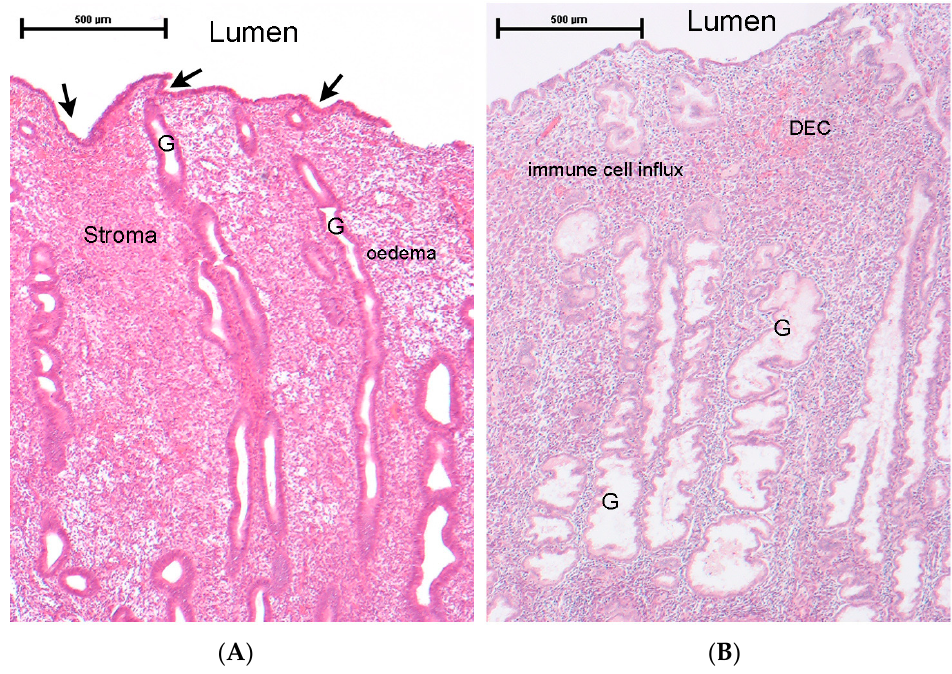
Figure 1. Histology of the human endometrium during the normal cycle. Full-thickness endometrial biopsies from hysterectomy specimens stained with haematoxylin and eosin. ( A ) Proliferative phase: note the presence of long curving glands (G) and some stromal oedema [23]. ( B ) Secretory phase: note the prominent glands (G), which have a dilated lumen and an irregular outer border stretching down into the basal compartment [24]. In the luminal (functional layer) immune cells are readily detected (most of these are likely to be macrophages and uterine natural killer (uNK) cells [17,19]), as are areas of decidualised fibroblasts (DEC) close to arterioles.